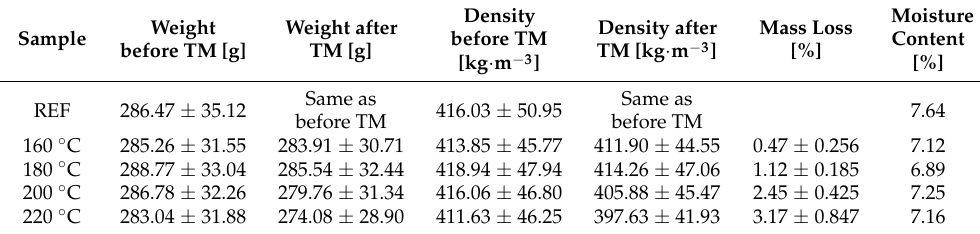
Figure 2. Technological parameters of the modification process of heat-treated wood at 160 °C ( a ), and at 200 °C ( b ). Table 1. Characteristics of